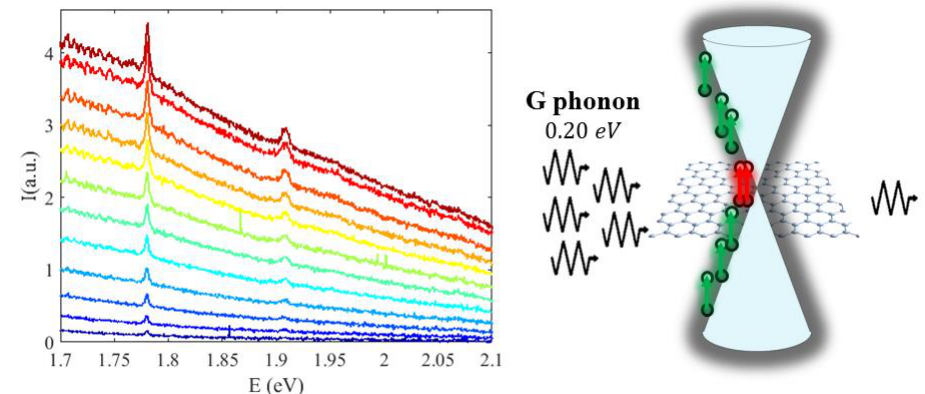
Fig. 1. (Left) Pulsed Raman spectra of graphene upon increasing electronic temperatures (from blue to red traces). (Right) Sketch of the smearing out of the Dirac cone. The red arrows indicate